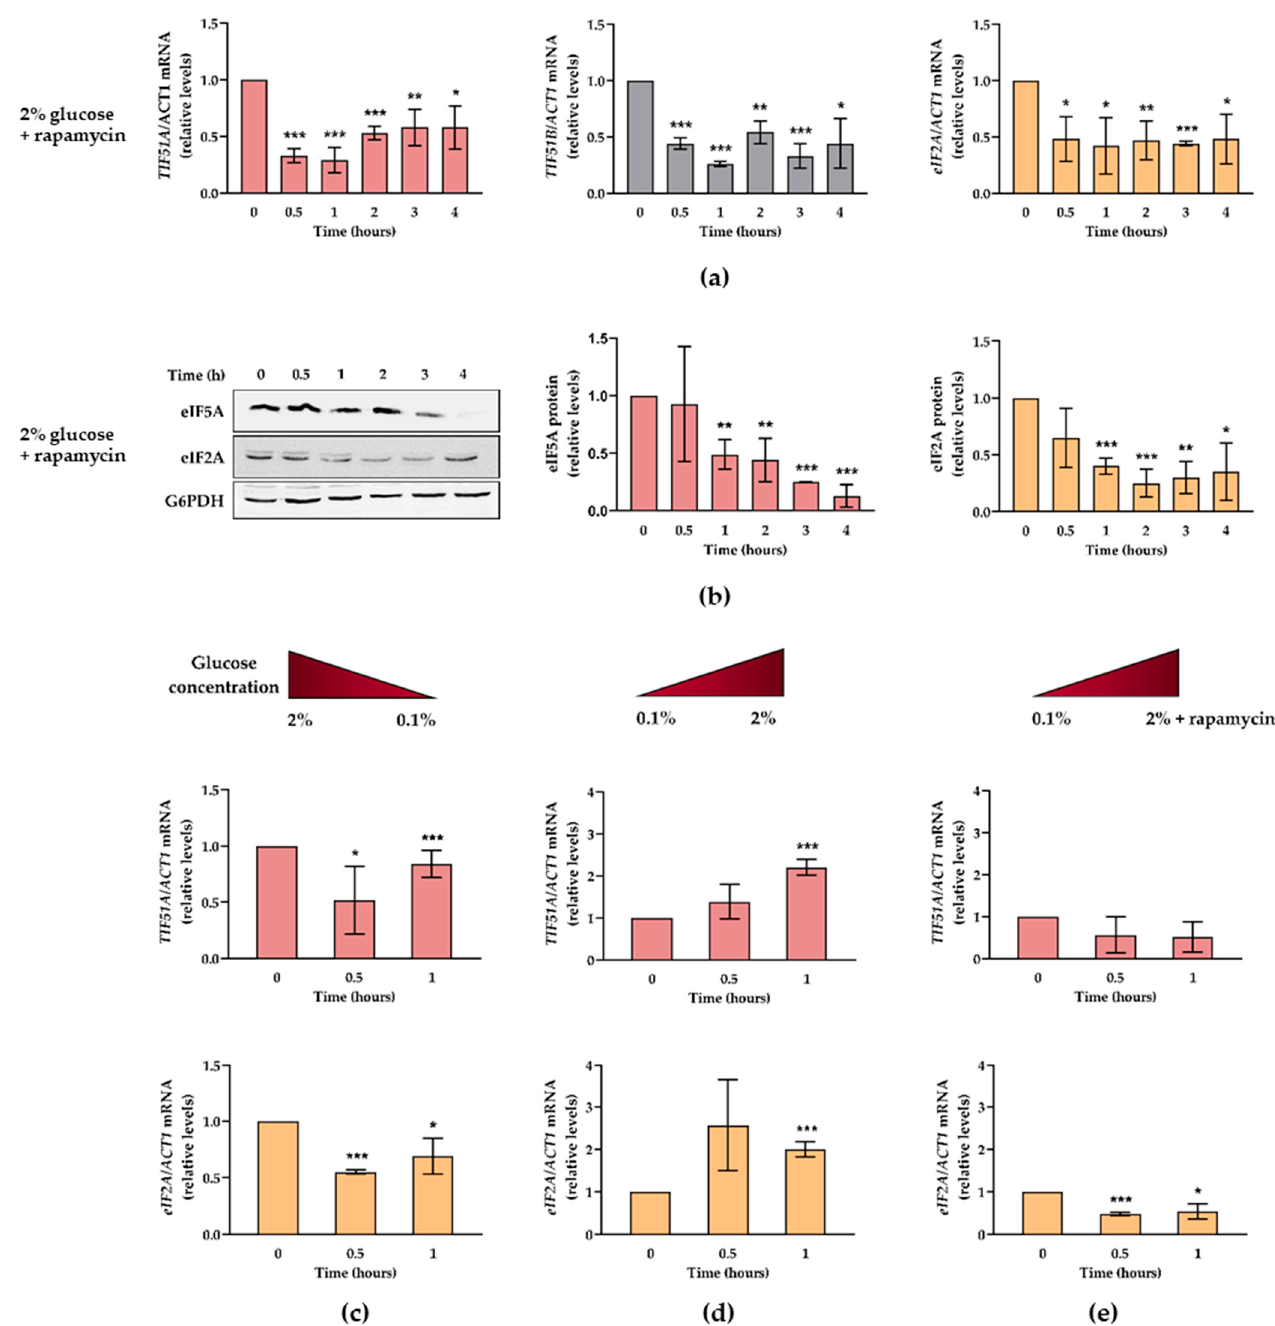
Figure 4. eIF5A expression is regulated by glucose concentration and TORC1 pathway. ( a , b ) WT cells were grown in YPD medium with the addition of 200 ng/mL rapamycin for 4 h. ( a ) The relative TIF51A , TIF51B , and eIF2A (from left to right) mRNA levels were determined. ( b ) Western blotting and quantification analysis of proteins eIF5A and eIF2A (from left to right). G6PDH protein levels were used as loading controls. A representative experiment is shown of three independent experiments. ( c ) The WT cells were grown in the YEP medium containing 2% glucose and transferred to the YEP medium containing 0.1% glucose for 1 h. ( d , e ) The WT cells were grown in the YEP medium containing 0.1% glucose and transferred to the YEP medium containing 2% glucose without ( d ) or with ( e ) the addition of rapamycin for 1 h. ( c – e ) The relative TIF51A (up) and eIF2A (down) mRNA levels were determined. ( a – e ) The results are shown as the means ± SD of three independent experiments and are expressed in relation to the value for time 0. Statistical significance was measured by a Student’s t -test in relation to time 0. * p < 0.05, ** p < 0.01, *** p < 0.001.